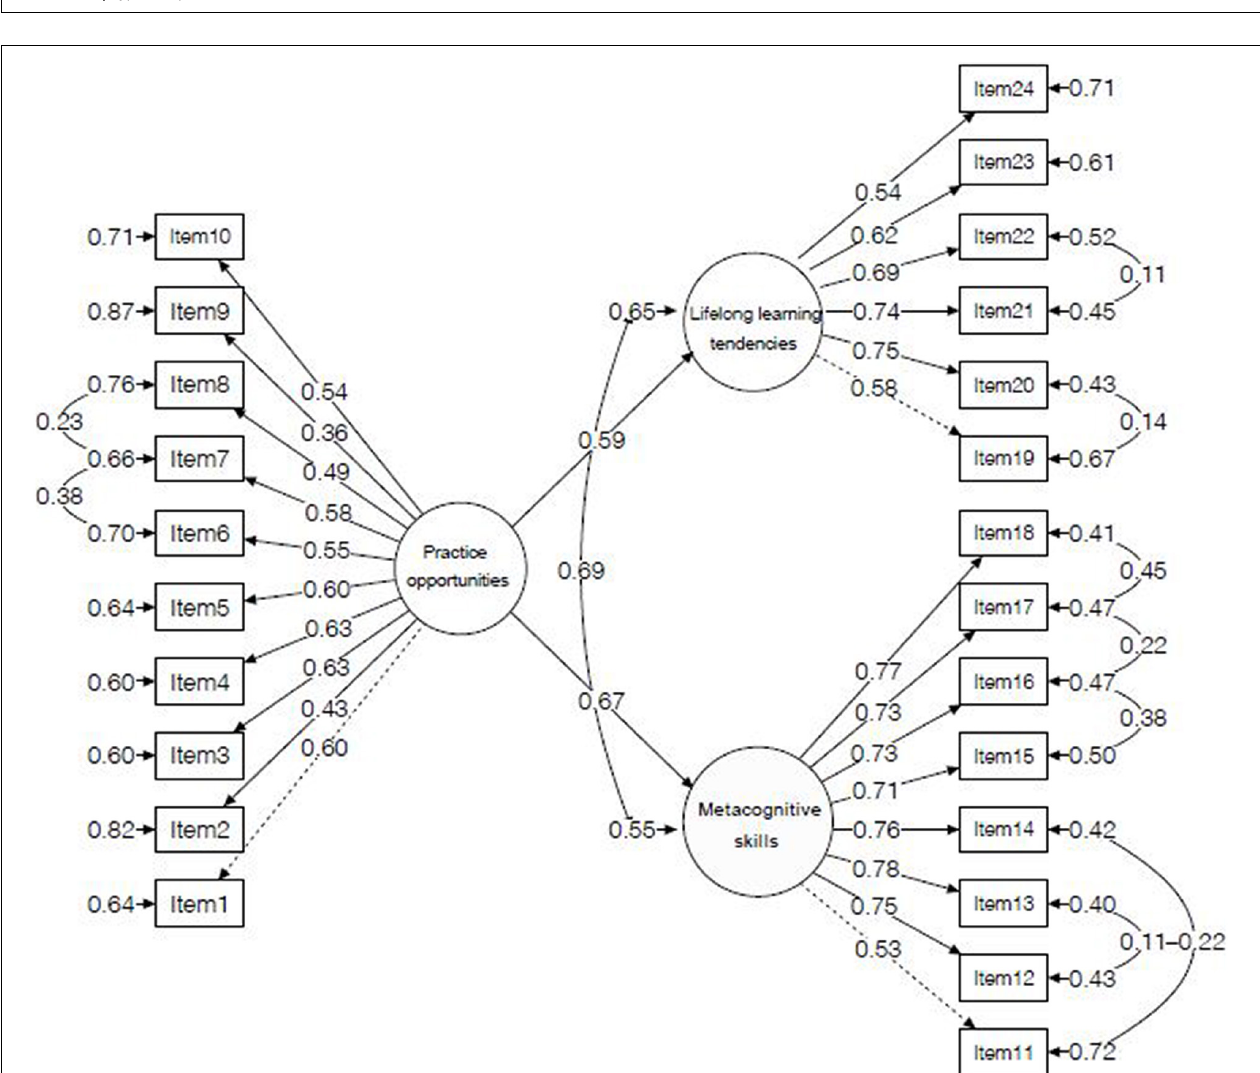
FIGURE 5 | Structural model with practice opportunities as a